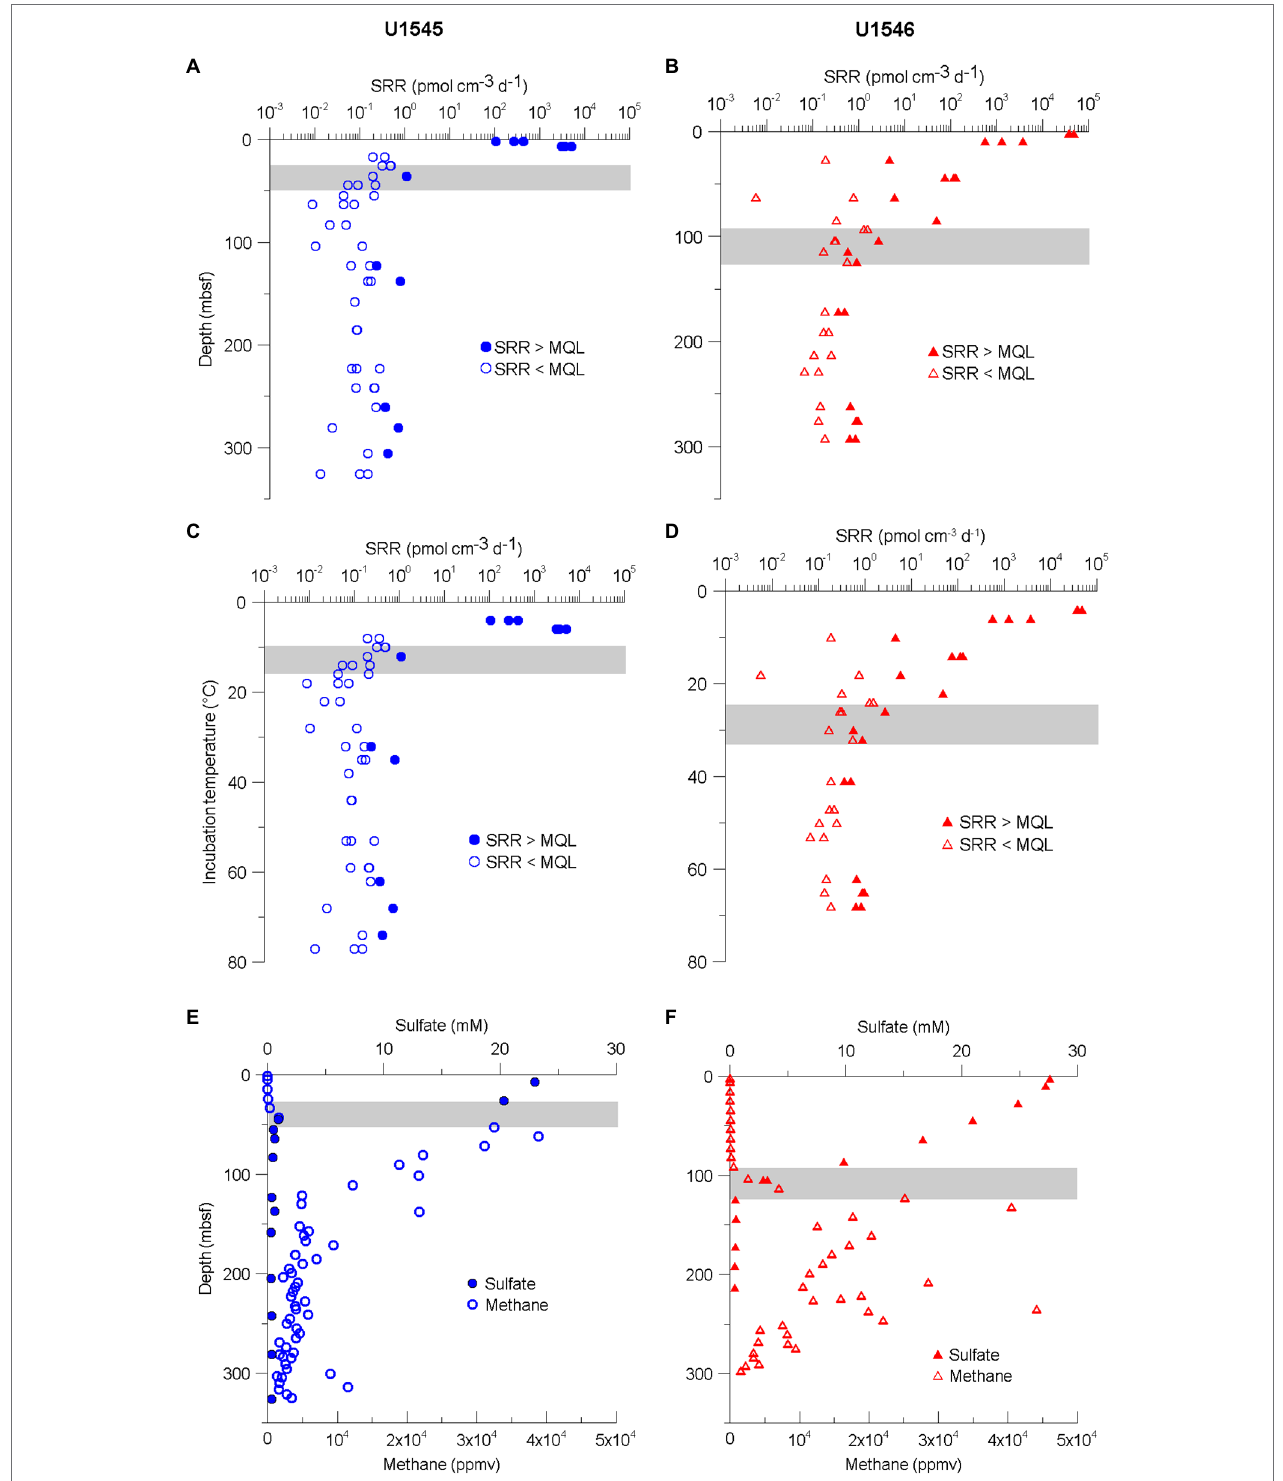
FIGURE 3 | (A,B) Sulfate reduction rates (SRR) for sites U1545C (blue circles) and U1546D (red triangles) plotted against sampled depth. Closed symbols indicate measurements SRR > MQL and open symbols MDL < SRR < MQL. See the definitions of MQL and MDL in the “Materials and Methods” section. (C,D) SRR for same sites plotted against incubation temperature. (E,F) Concentrations of sulfate and methane. The data were obtained from the Laboratory Information Management System (LIMS) report. Gray bar indicates Sulfate–Methane Transition Zone